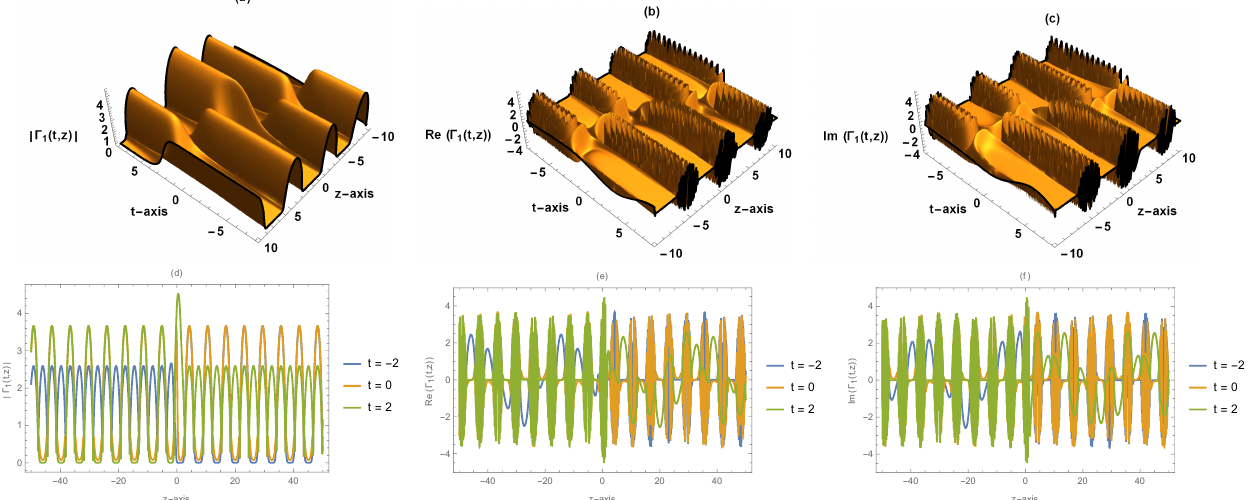
Figure 1. ( a , d ) Absolute value of Γ 1 ( t , z ) . ( b , e ) Real part of Γ 1 ( t , z ) . ( c , f ) Imaginary part of Γ ( t , z ) . The complex solitary wave solution Γ 1 ρ 1 ( z ) = sin ( z ) , ρ 2 ( z ) = − 1/4, ¯ h 0 ( z ) = cos ( z ) , ¯ h 1 ( z ) = 1, q ( z ) = − 2sech 2 ( z ) , κ = − 1/2, θ = 1/5. Geometrical pattern 2 (k = 3 ) . Solution with exponential function